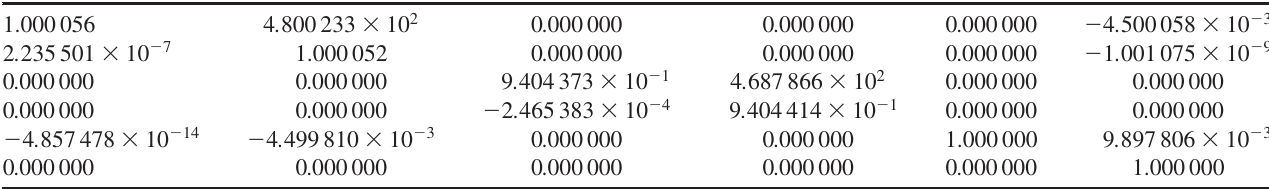
TABLE II. Linear transfer map R 2 for the ILC damping ring wiggler.